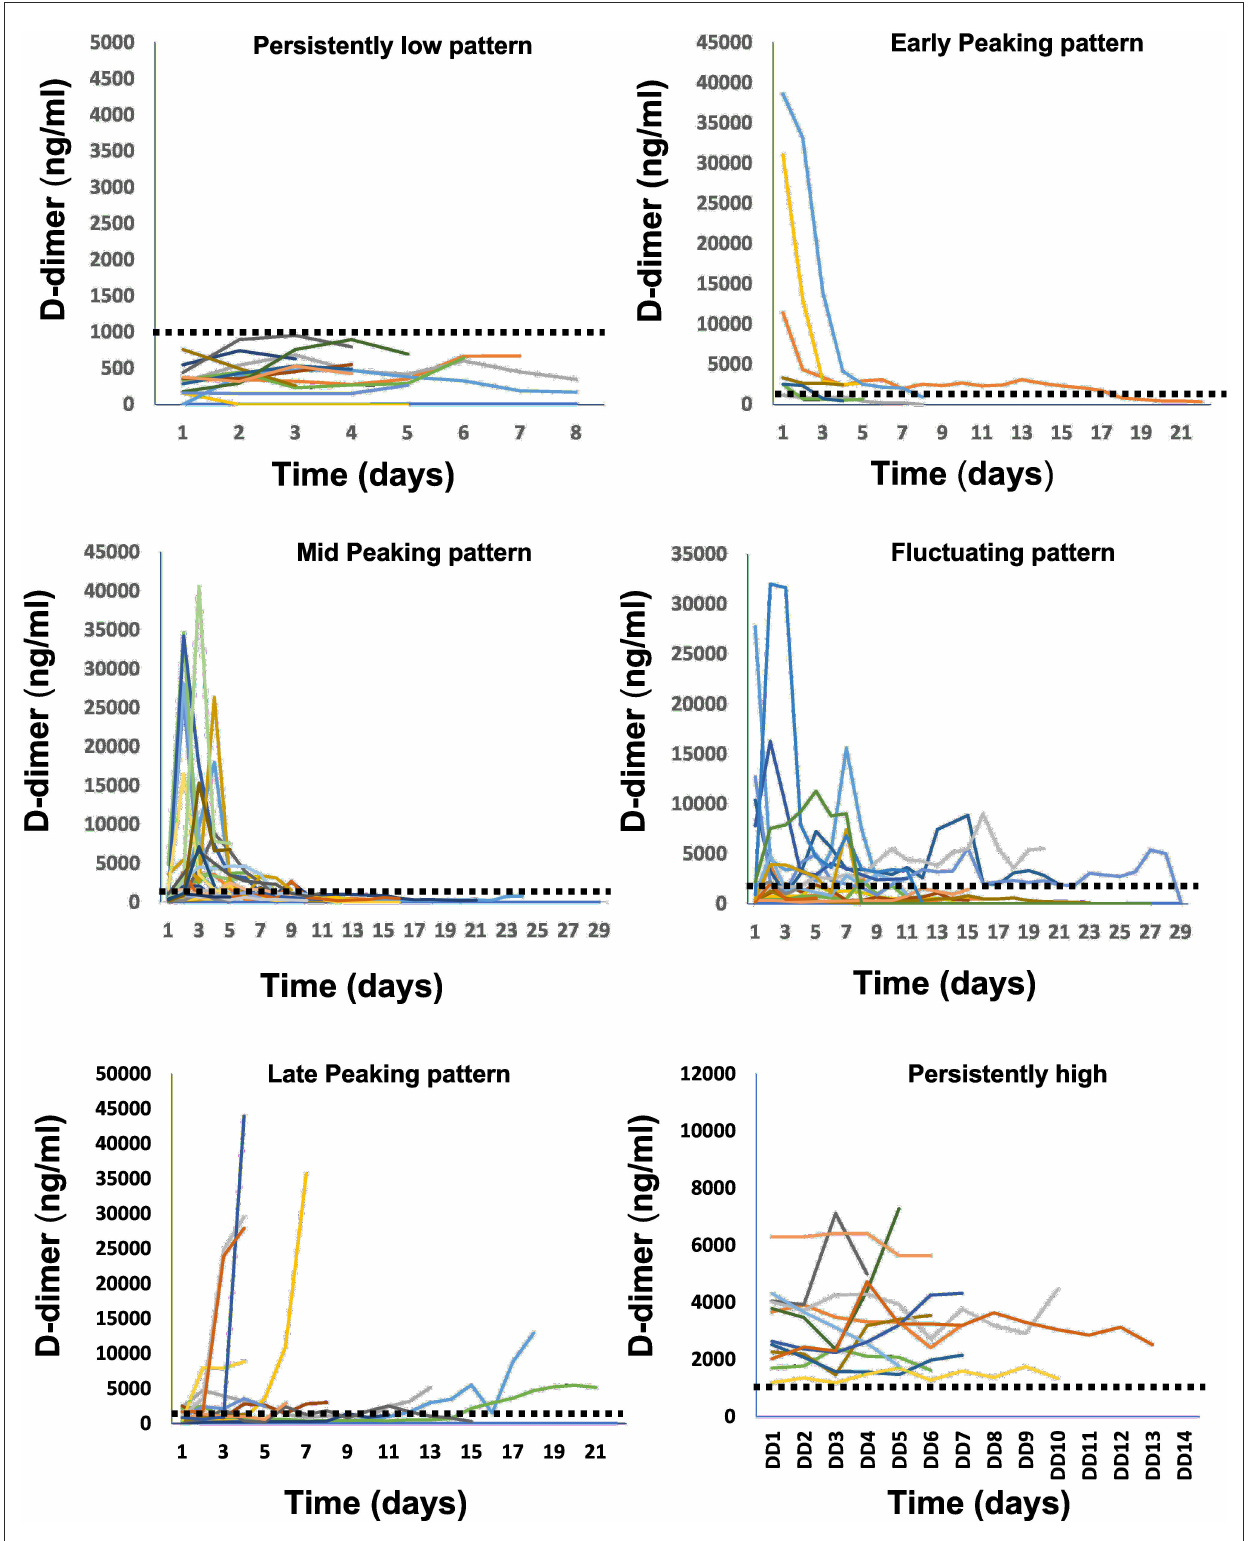
FIGURE2 Examples of in-hospital D-dimer patterns observed in our study from different patients. Each curve represents D-dimer behavior measured from repeated samples during the hospitalization time for a separate